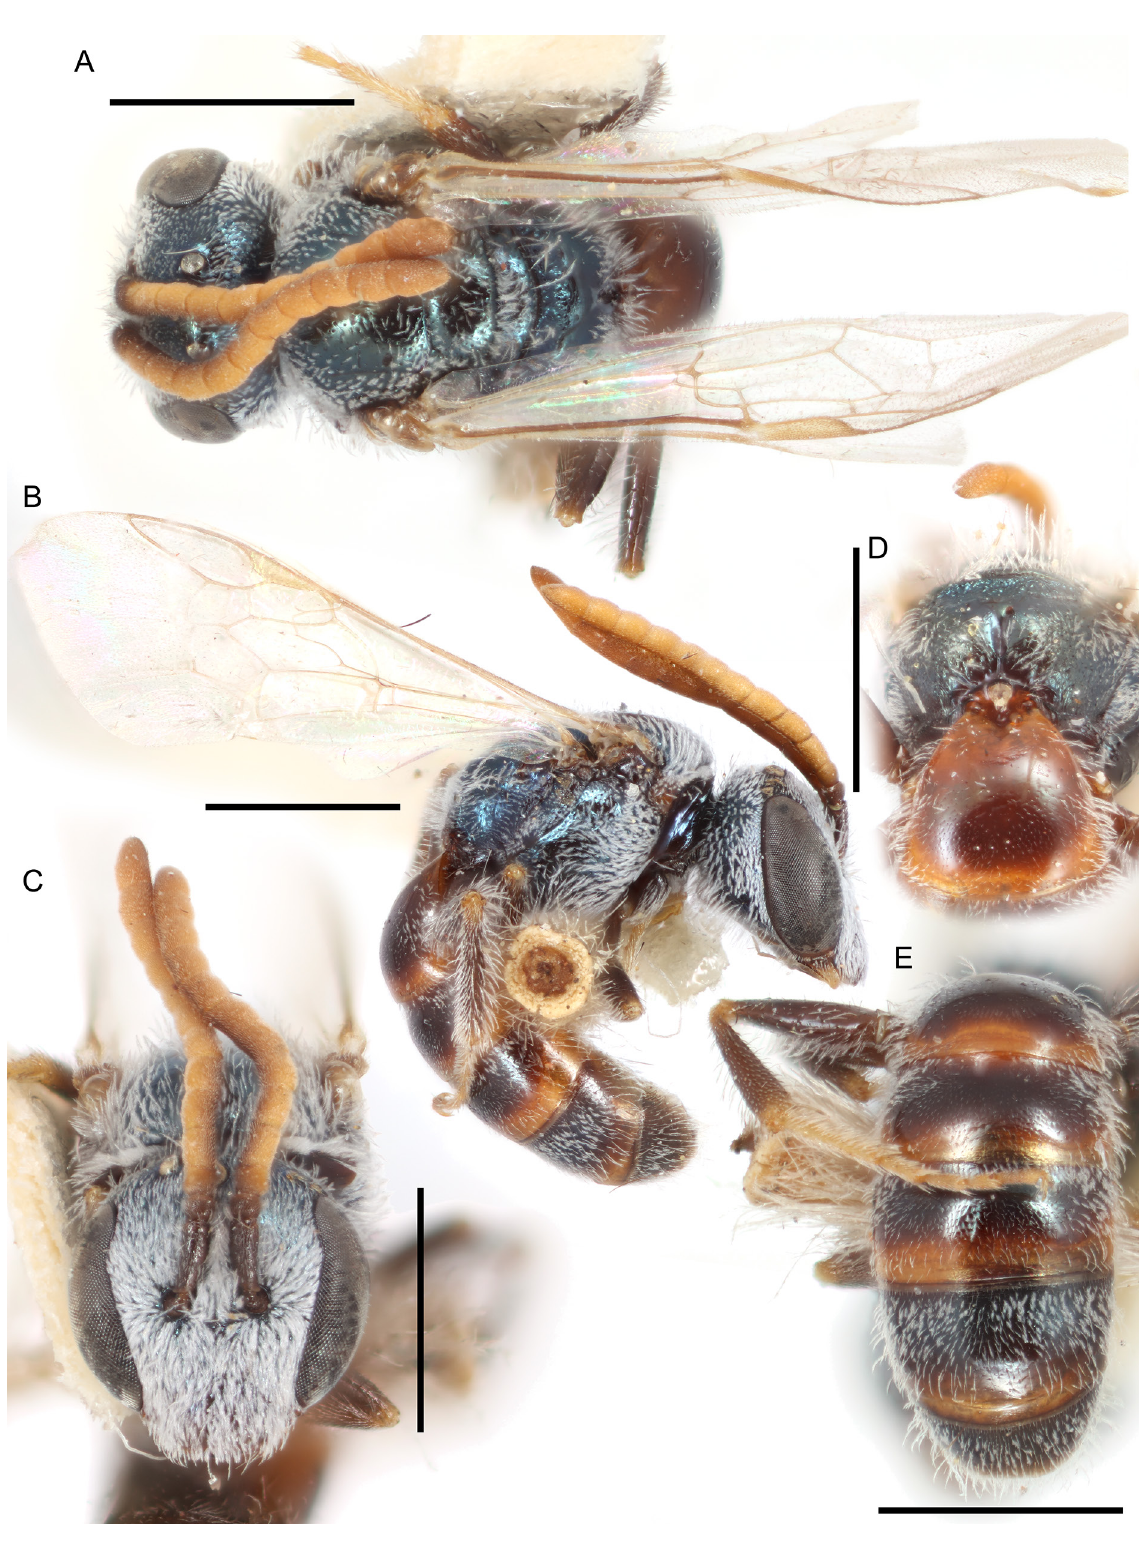
Fig. 50. Lasioglossum ( D. ) kunzei (Cockerell, 1898), ♂. A . Dorsal habitus. B . Lateral habitus. C . Face. D . Propodeum. E . Metasoma. Scale bars: 1